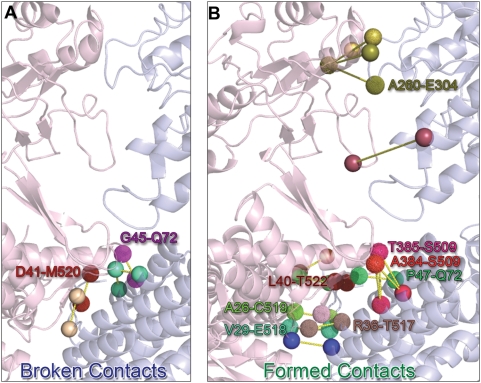
Redistribution of inter-residue contacts at the transition from R
to R″ state.Panel (A) shows the inter-residue contacts between adjacent subunits
of the cis ring, which break up during the
transition. The two subunits are colored in light pink and blue.
Contact pairs are represented by spheres at the
Cα position, and by distinctive colors.
Similarly, panel (B) shows the contacts newly formed during the
transition. See Table
7 for the complete list of residue pairs shown here. The
contacts involving a pair of conserved residues are labeled using
the same colors as the corresponding residues.